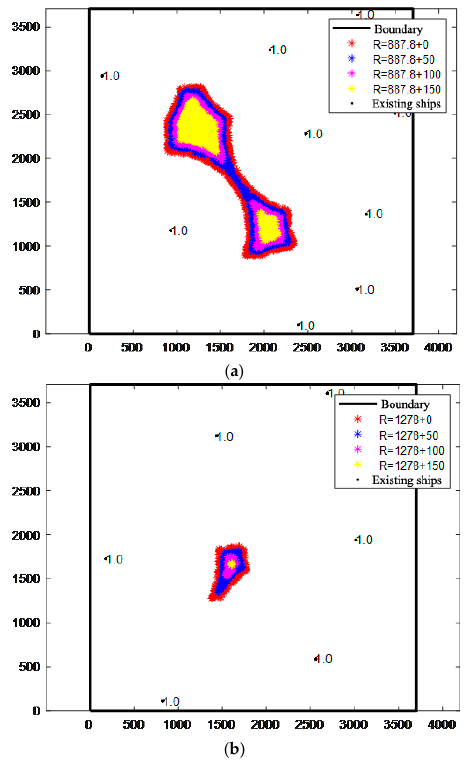
Figure 10. Schematic diagram of mooring area detection with wind force >7 and water depth of 20 m. ( a ) Represents 192 m and 192 m ship type mooring area detection. ( b ) Represents 333 m and 333 m ship type mooring area detection.